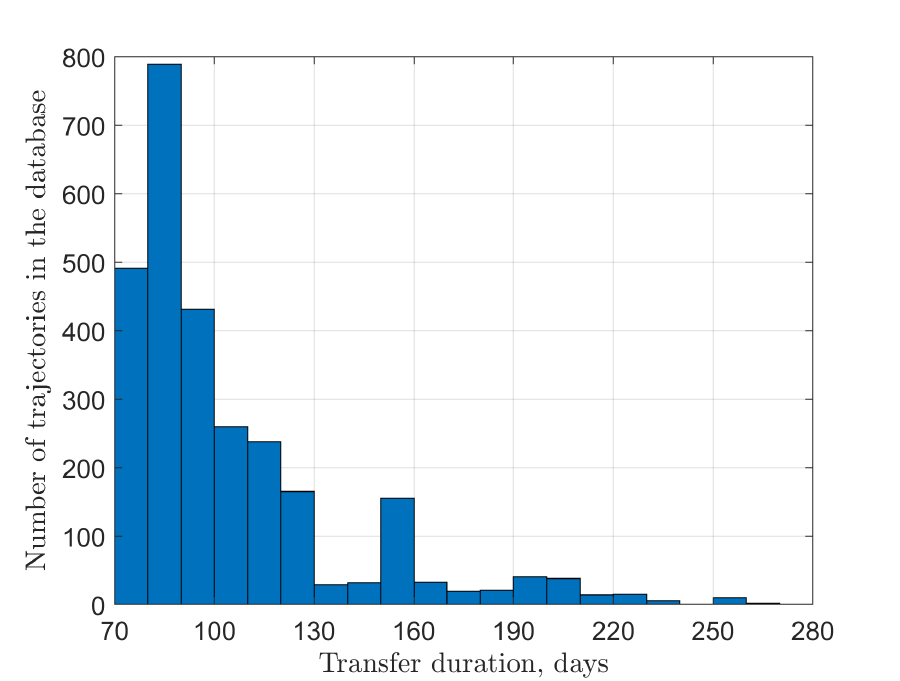
Figure 19. Distribution of the total transfer duration for SALT trajectories without a lunar flyby.